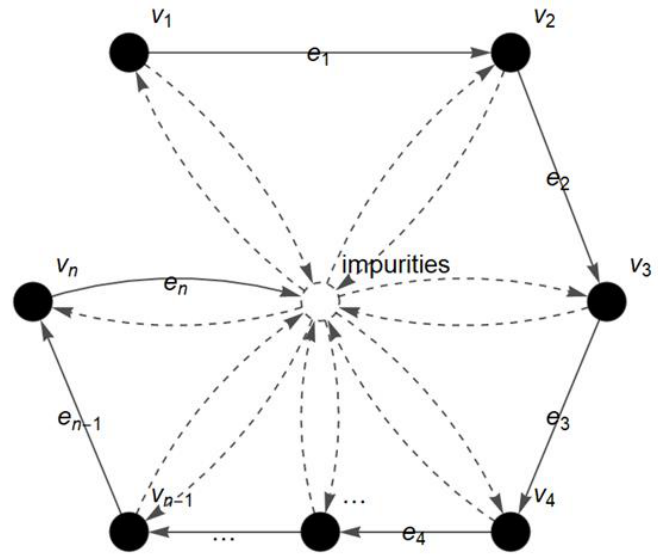
Figure 2. Fuzzy autocatalytic set (FACS) graph of FTIR gelatin spectra.